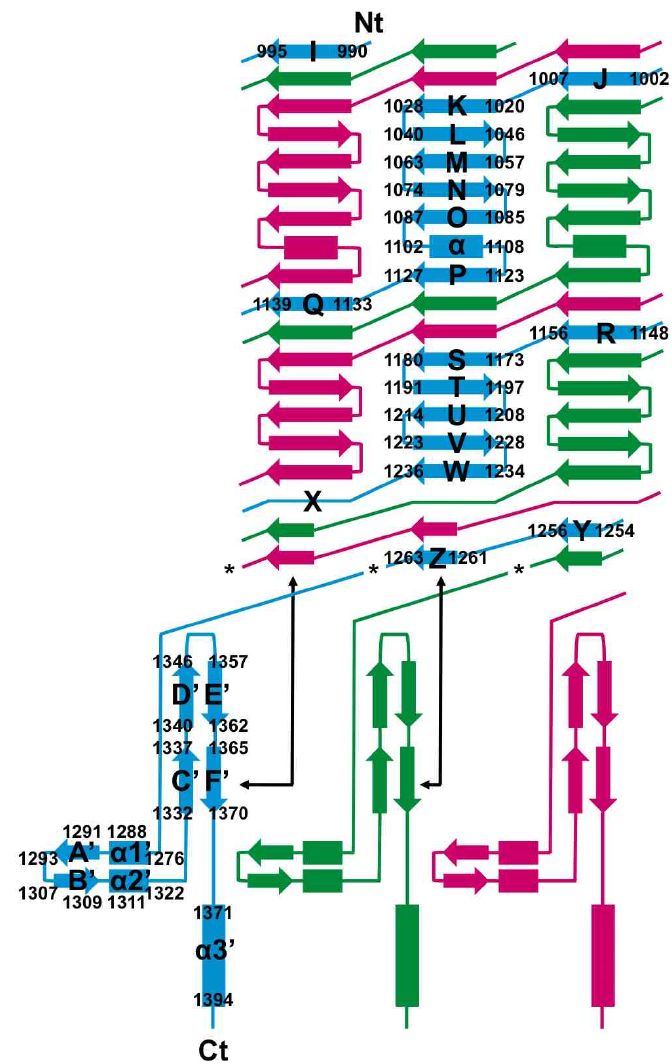
Figure 3. Topology diagram of pb1(970–1396). Beta-strands are represented as arrows and alpha helices as rectangles. Secondary structure elements are labelled for the cyan monomer. Asterisks indicate the location of the scissile Ser1264. The two-way arrows indicate the interaction completing the YZF ′ C ′ beta-sheet. The beginning and end of each secondary structure element is labelled with the residue number.